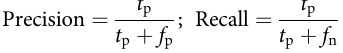
decaying learning rates starting at